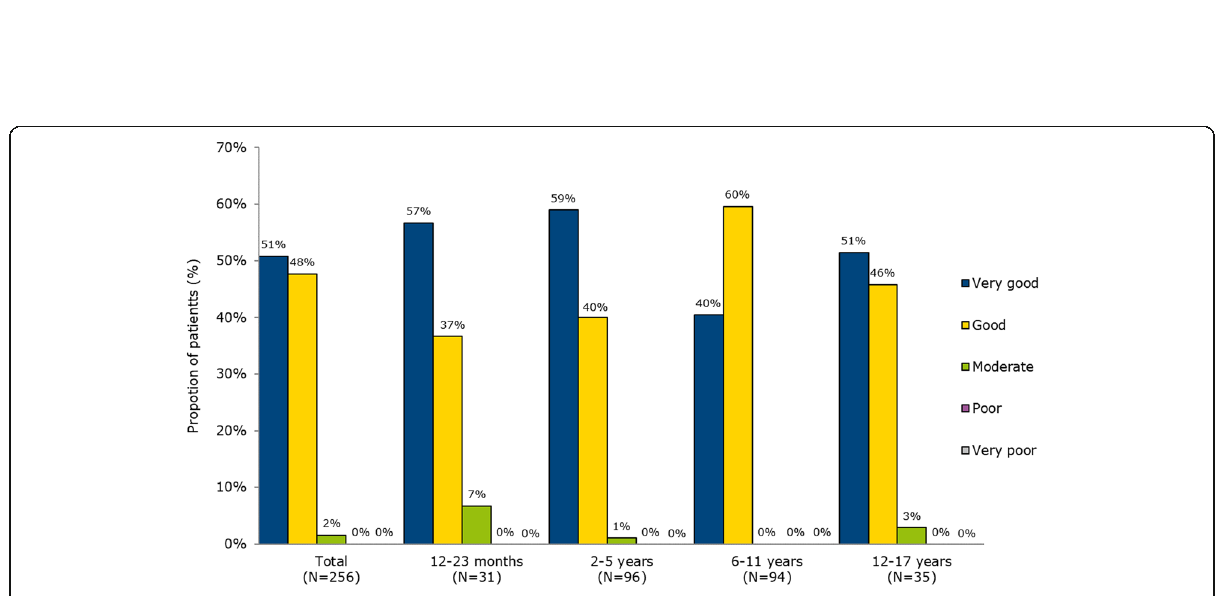
Fig. 9 Patients ’ assessment of tolerability at end of study